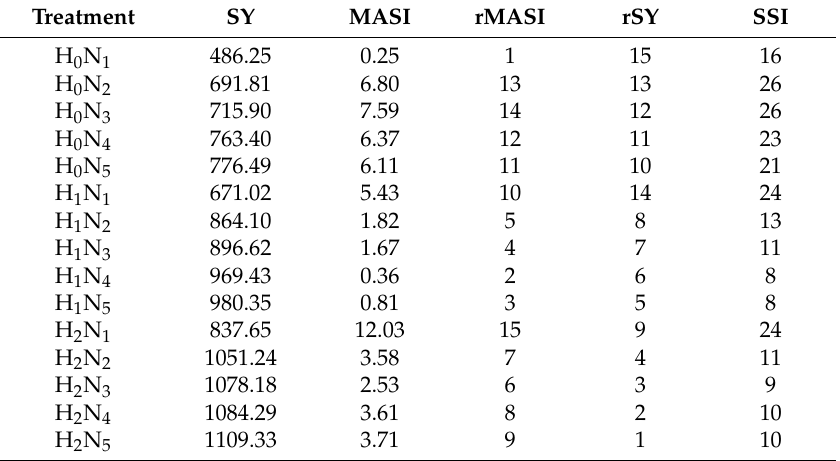
Table 5. Economics of lentil as influenced by the application of hydrogel and foliar nutrition (average Table 7. Ranking of hydrogel and nutrition treatment combinations on the basis of yield and stability. data of three years).